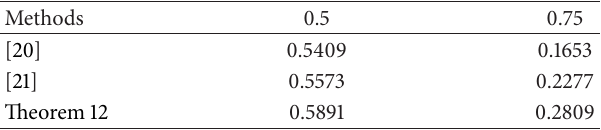
Table 1: Maximum sampling interval p for different 𝑐 20